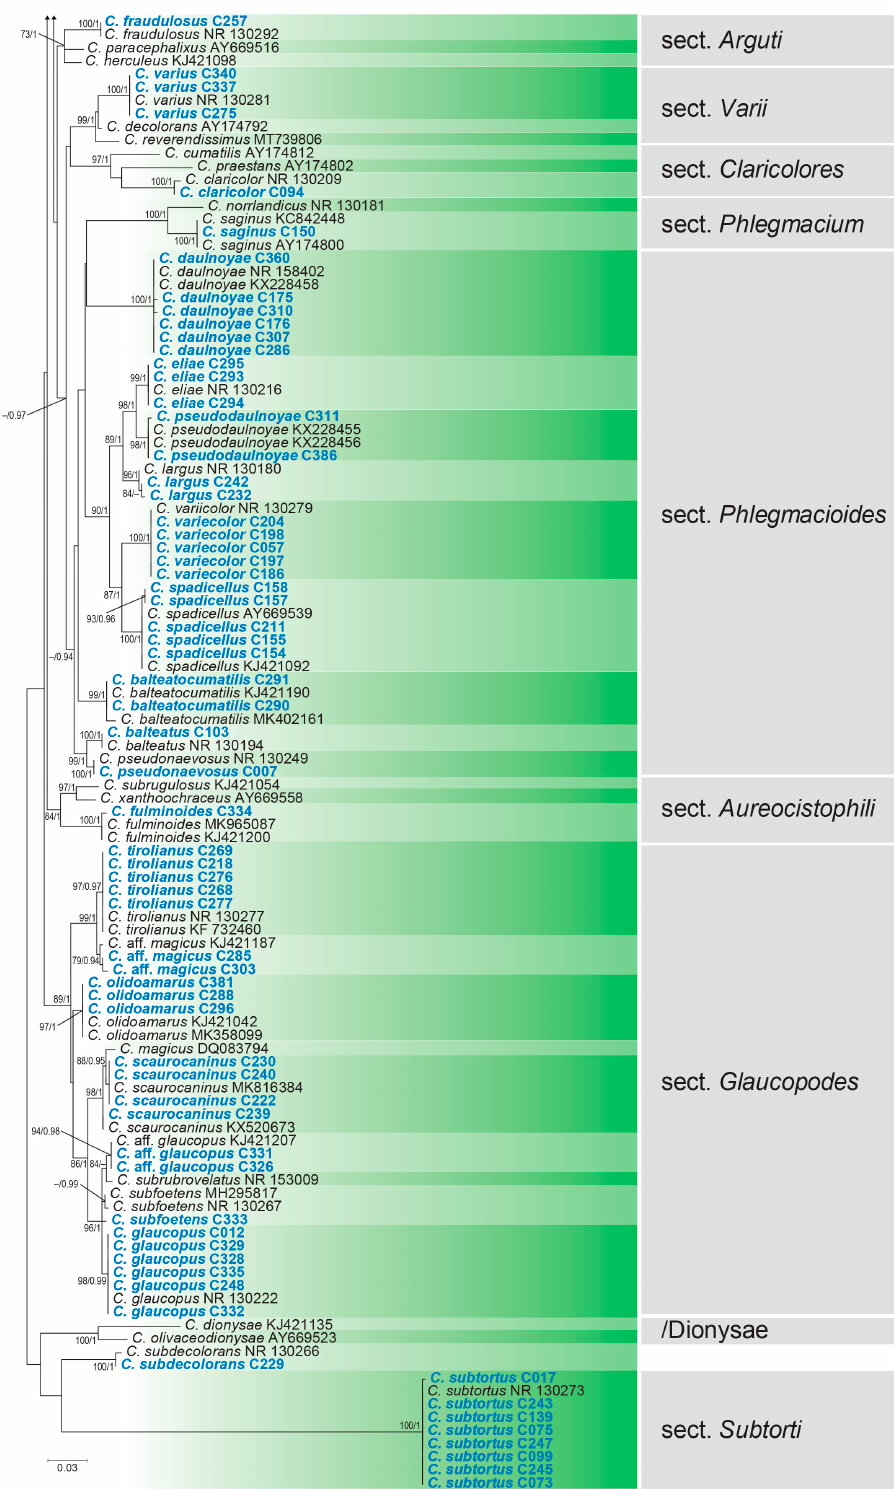
Figure 4. Maximum likelihood phylogenetic tree of the phlegmacioid sections/clades of the genus Cortinarius s.l. based on nrDNA ITS sequence analyses with gap coding. Sequences produced in this study are in blue and boldface and labelled with their voucher numbers. Sequences from public repositories are marked with their GenBank/UNITE accession numbers. ML bootstrap values of >70% as well as Bayesian posterior probabilities of >0.9 are placed above or below branches. The scale bar indicates 0.03 expected change per site per branch.